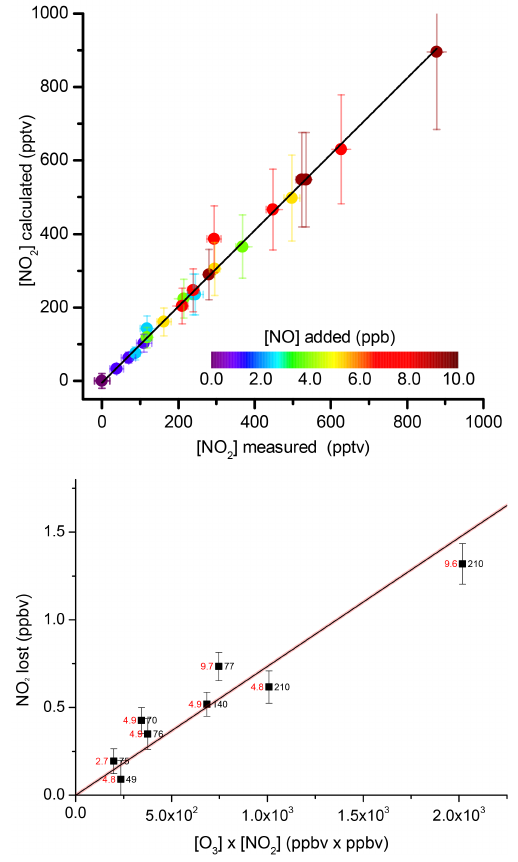
Figure 6. Upper panel: NO 2 formation in the reaction of O 3 (25, 48 or 80ppbv) with NO in the inlet (in this case at ambient tempera- ture), and reference cavity (at 308K) and connecting tubing. The er- ror bars on the calculated NO 2 formed are derived from the ∼ 20% error in the rate coefficient given for the rate coefficient (Atkinson et al., 2004). The fit to the data (black line) yields a slope of 1.04 ± 0.08. Lower panel: loss of NO 2 as a result of the thermal decom- position of O 3 to O atoms and Reaction (R11). The black numbers to the right of each symbol indicate the O 3 mixing ratio (ppbv); the red numbers to the left represent the initial NO 2 amount (in ppbv). The straight black line is a weighted fit to the data with a slope of 7.34 × 10 − 4 ppbv − 1 . The transparent red line is the NO 2 loss (in ppbv) calculated as described in the text with [O] ss = [O 3 ] /